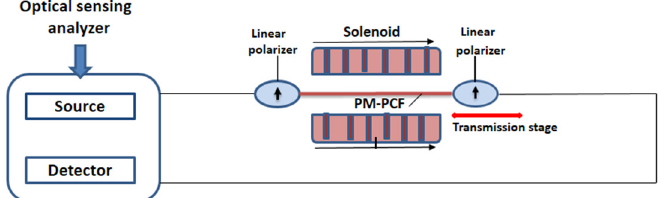
Figure 30. Experimental set up for magnetic field detection using polarization-maintaining PCF filled with Fe 3 O 4 nanofluid (Reproduced from [97], with the permission of AIP